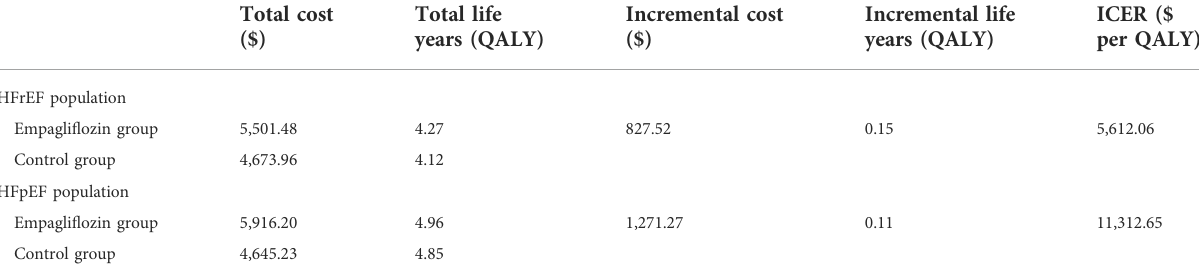
TABLE 3 The results from base-case